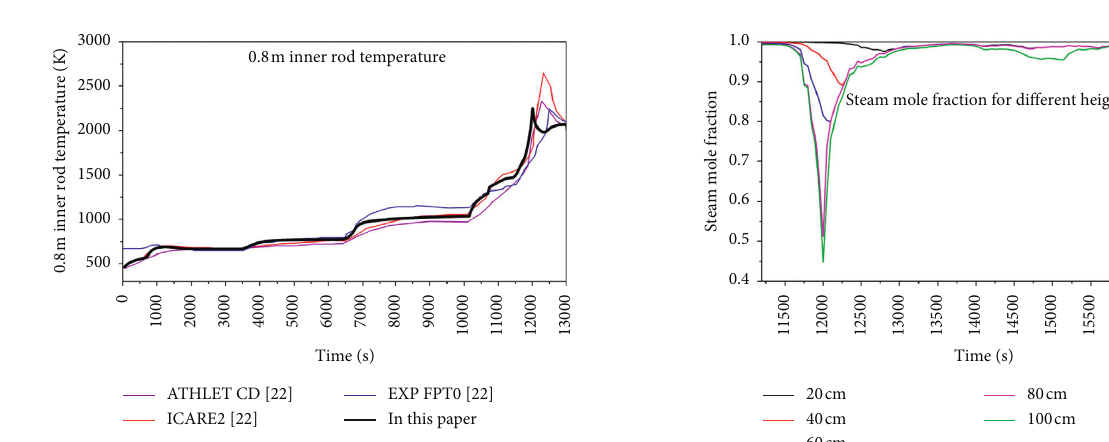
Figure 18: Variation of inner ring fuel rod temperature at 0.8m.